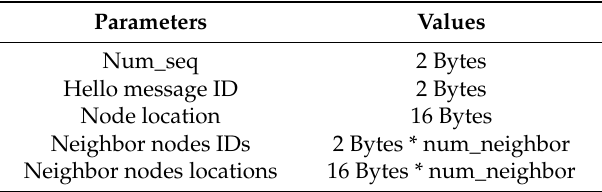
Table 2. Format of Hello